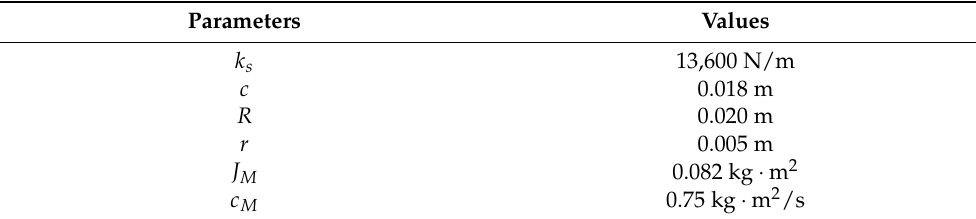
Table 2. Parameters of the SEA.